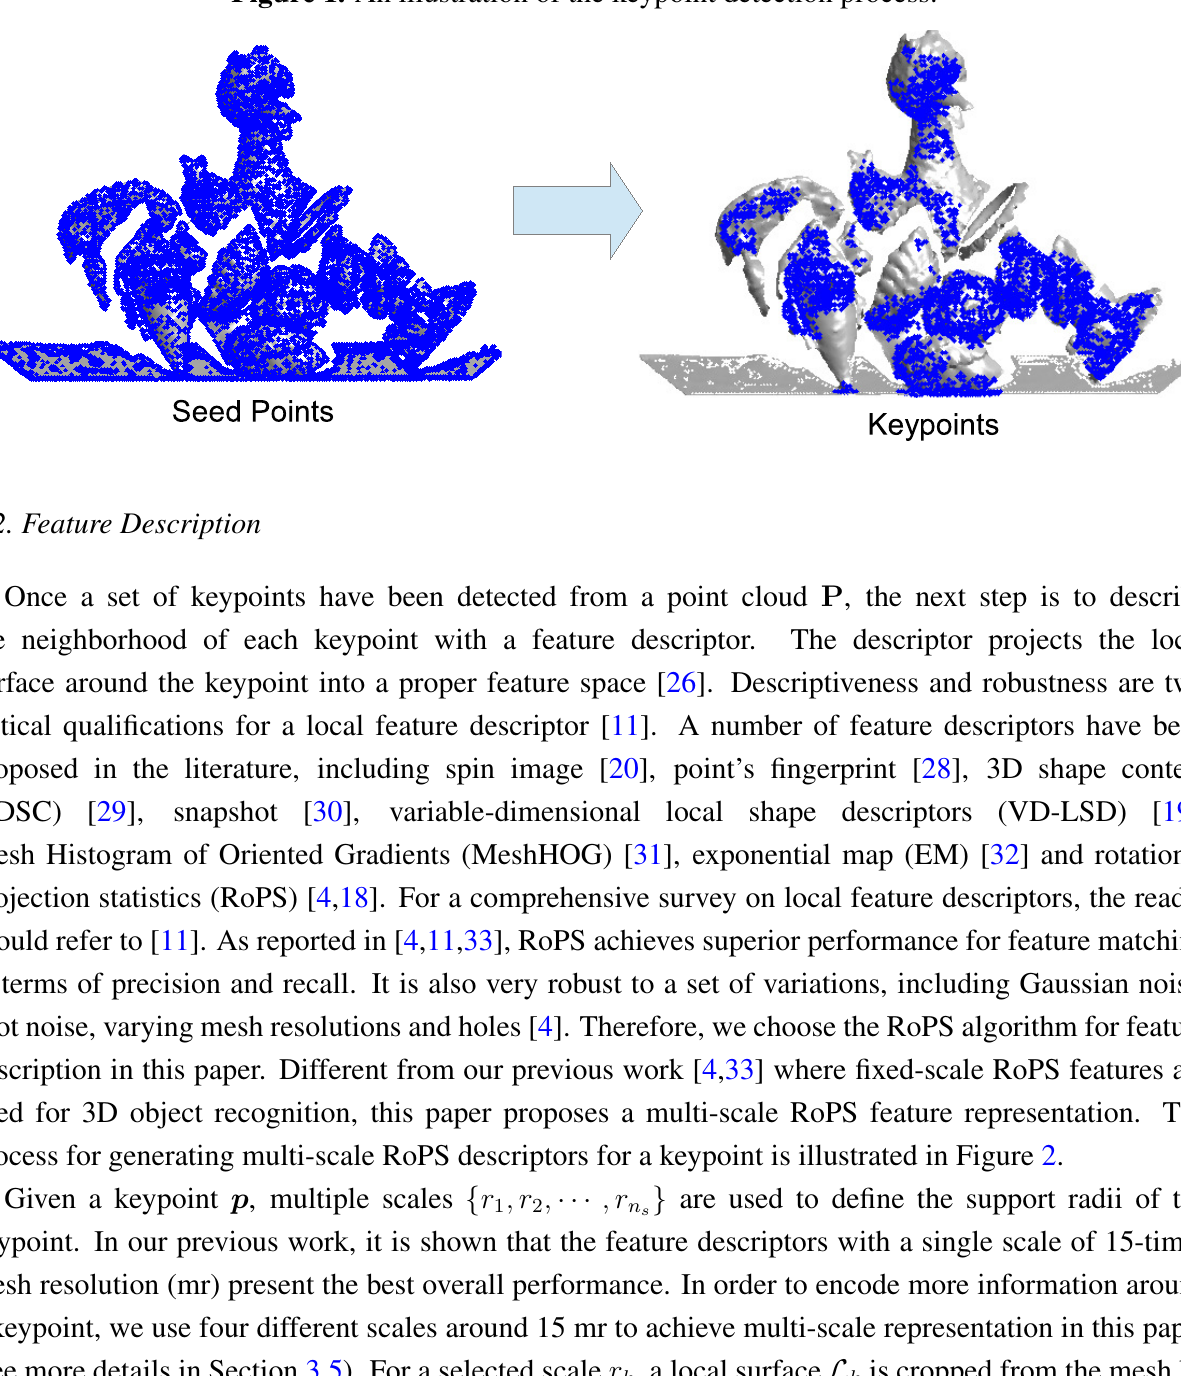
Figure 1. An illustration of the keypoint detection